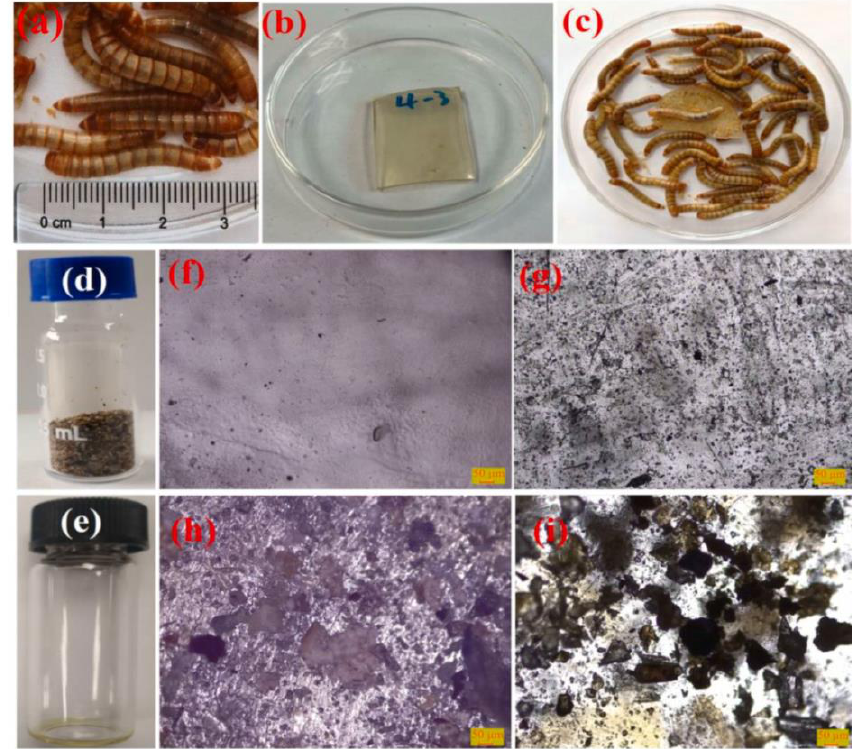
Figure 1. ( a ) Representative images of Tenebrio molitor ; ( b ) bio-based cross-linked polymer film used in biodegradation experiment; ( c ) Tenebrio monitor fed with bio-based cross-linked polymer film for 30 days. ( d ) Feces of Tenebrio molitor collected in biodegradation experiment. ( e ) Extraction from feces of Tenebrio molitor using tetrahydrofuran (THF). ( f ) Microstructures of bio-based cross-linked polymer film in a reflection mode. ( g ) Microstructures of bio-based cross-linked polymer film in a transmissive mode. ( h ) Microstructure of bio-based cross-linked polymer films after feeding Tenebrio molitor for 30 days in a reflection mode. ( i ) Microstructures of bio-based cross-linked polymer 3 film after feeding Tenebrio molitor for 30 days in a transmissive mode, reprinted with permission from [30].